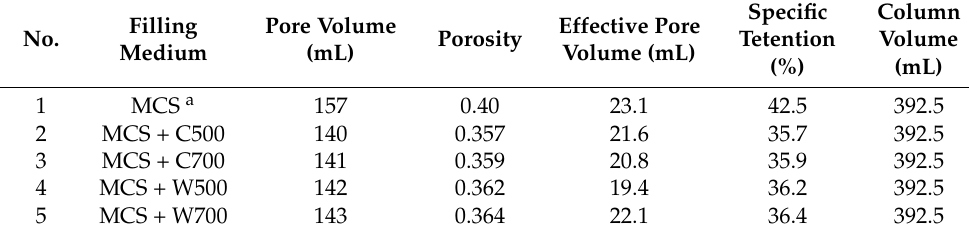
Table 5. Parameters of each